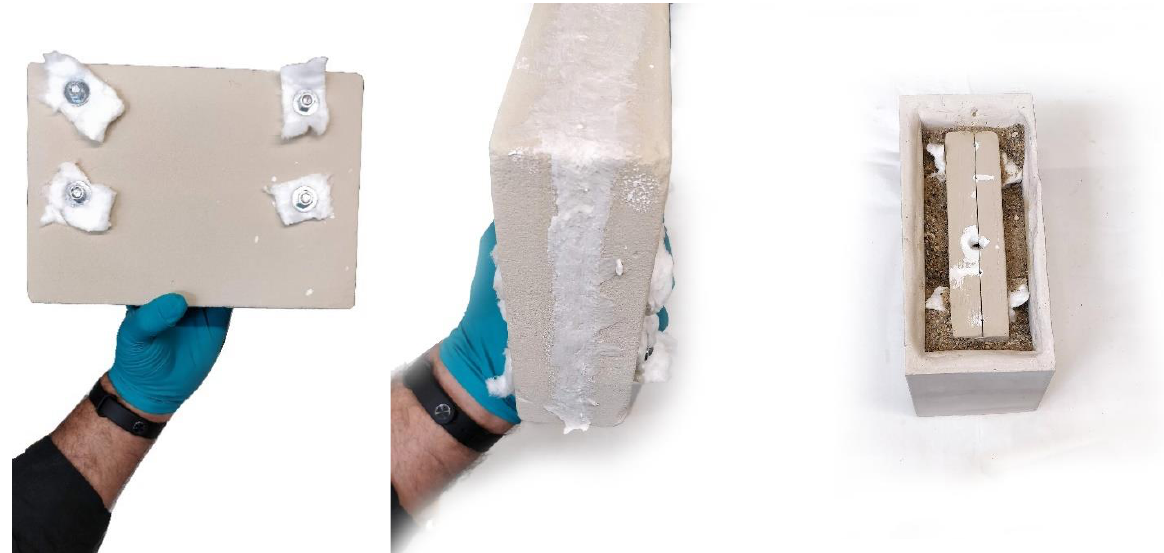
Fig. 9 Safety measures employed at the 3D-printed sand moulds prior to casting (Geometry 1). Table 6 provides an overview of the observations derived from this test series. It can be concluded